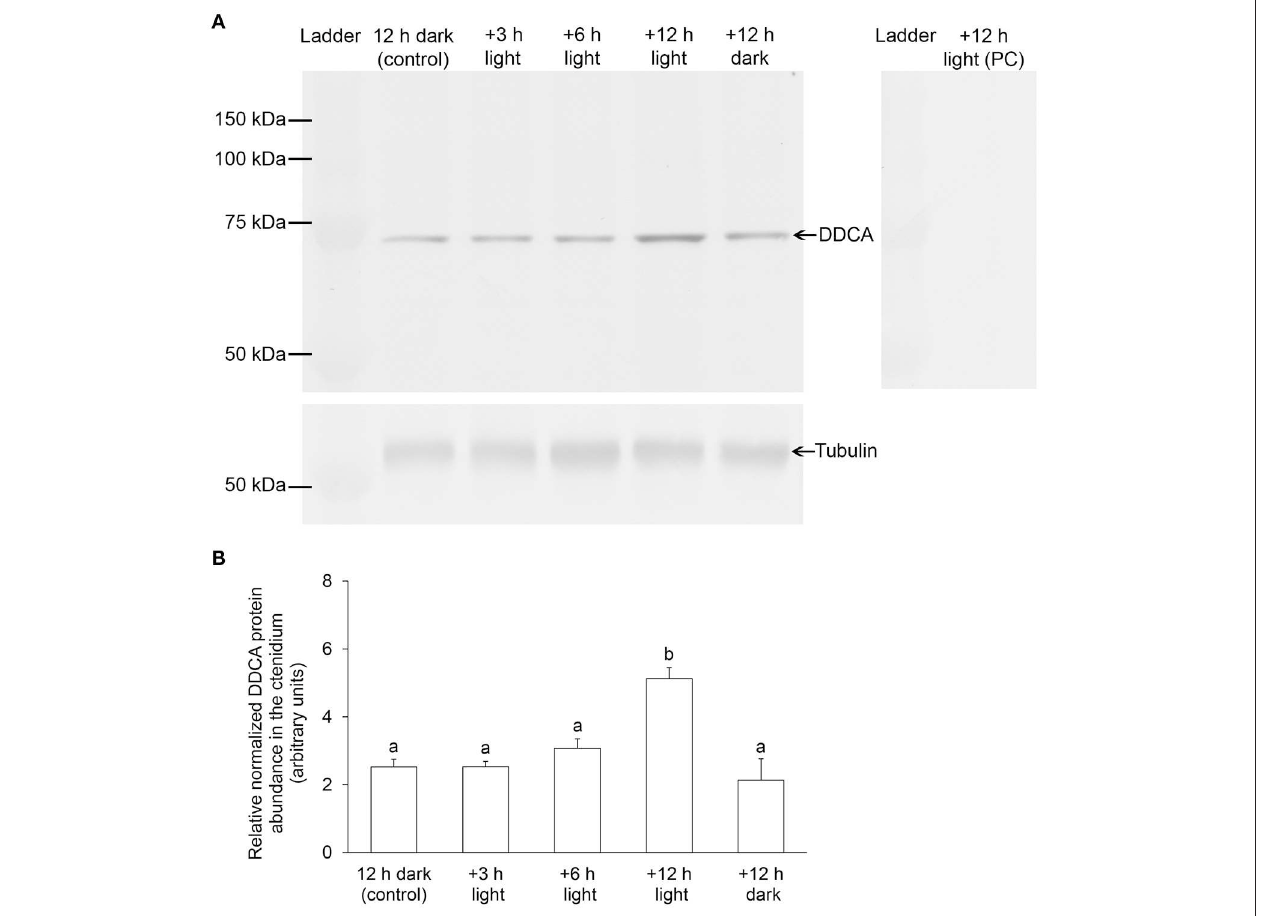
FIGURE 5 | Effects of light on the protein abundance of Dual Domain Carbonic Anhydrase (DDCA) in the ctenidium of Tridacna squamosa . The protein abundance of DDCA in the ctenidium of T. squamosa kept in darkness for 12h (control), or exposed to light for 3, 6 or 12h, or kept in darkness for another 12h (a total of 24h in darkness). (A) Examples of an immunoblot of DDCA and tubulin (reference protein), and an immunoblot of DDCA using the anti-DDCA antibody pretreated with peptide competition (PC). (B) The optical density of the DDCA band for a 25 µ g protein load was normalized with respect to that of tubulin. Results represent means + S.E.M. ( N = 4). Means not sharing the same letter are significantly different from each other ( P <